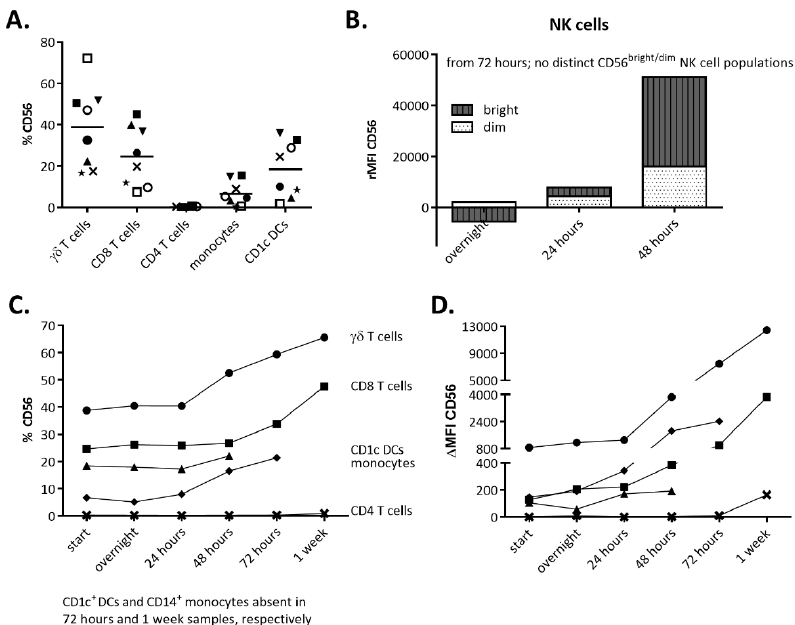
Figure 6. Cluster of differentiation (CD)56 expression and kinetics following interleukin (IL)-15 stimulation. ( A ) CD56 surface expression on different immune cell subsets in fresh peripheral blood mononuclear cells (PBMCs) as determined by flow cytometry. Donors are represented by unique symbols ( n = 8). ( B – D ) PBMCs (1 × 10e 6 cells / mL) were stimulated with 10 ng / mL recombinant